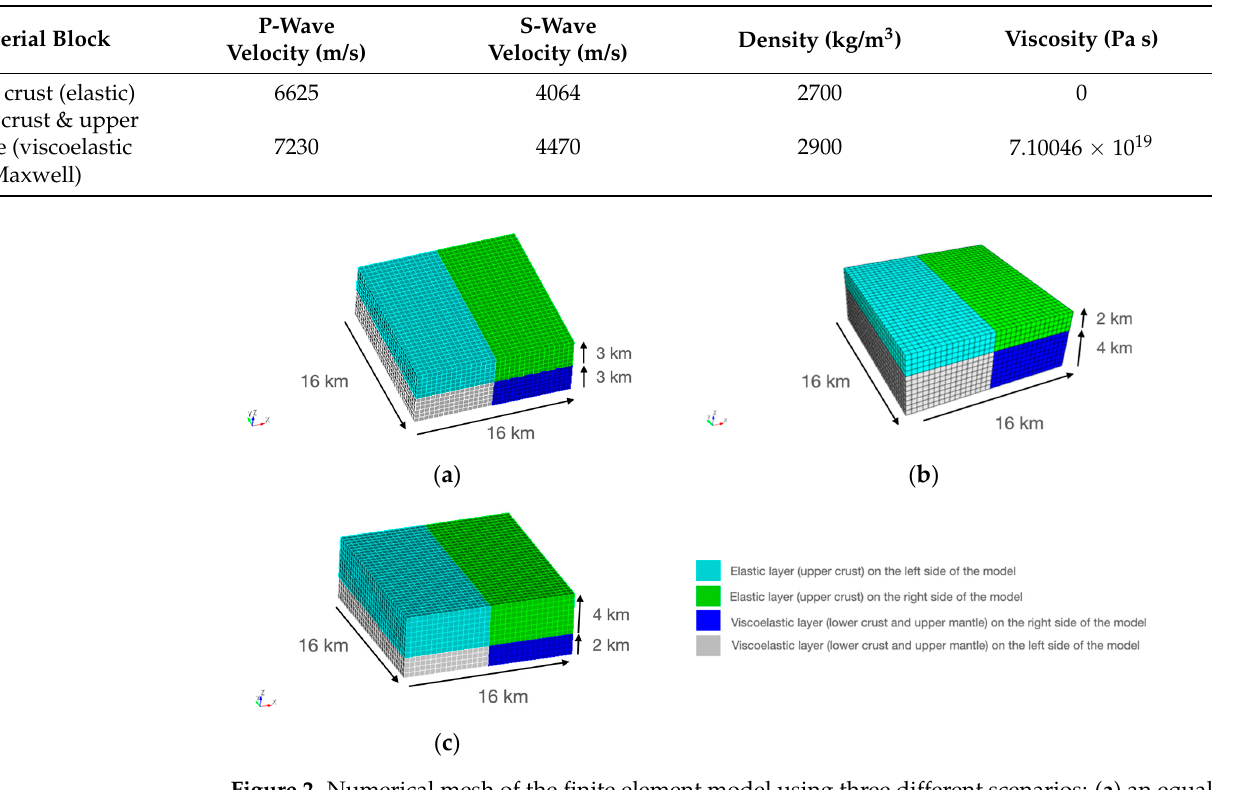
Figure 2. Numerical mesh of the finite element model using three different scenarios: ( a ) an equal thickness of 3 km for the elastic upper crust ( upper mesh layer) and the viscoelastic lower crust and upper mantle ( lower mesh layer) as scenario one; ( b ) a thinner elastic upper crust layer (2 km) than the viscoelastic layer (4 km) as scenario two; and ( c ) a thicker elastic upper crust layer (4 km) than the viscoelastic layer (2 km) as scenario three.